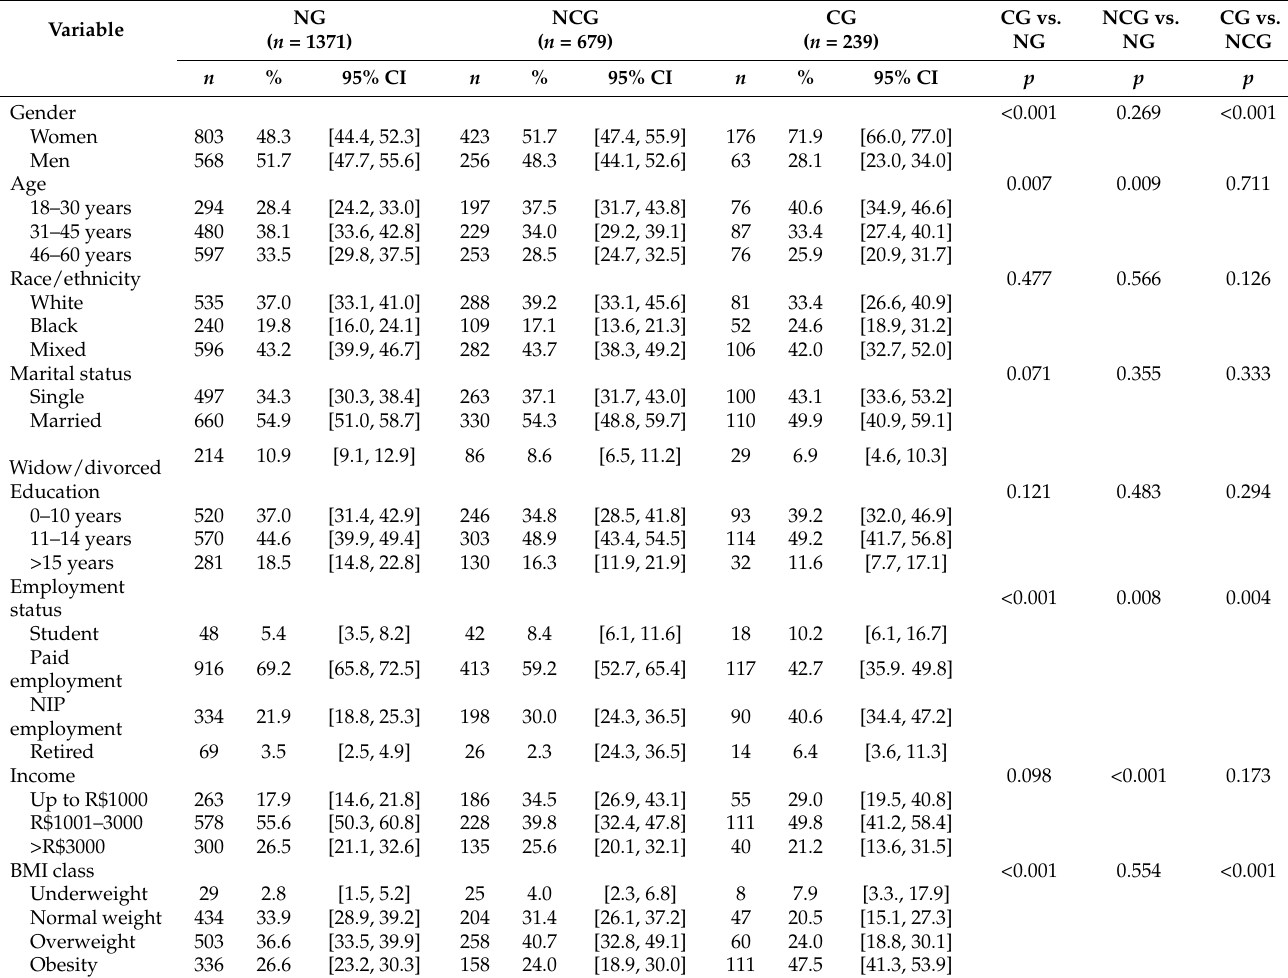
Table 1. Sociodemographic and weight characteristics according to grazing